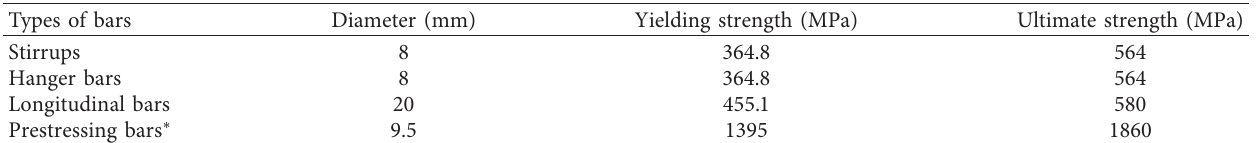
Table 4: Mechanical parameters of reinforced bars